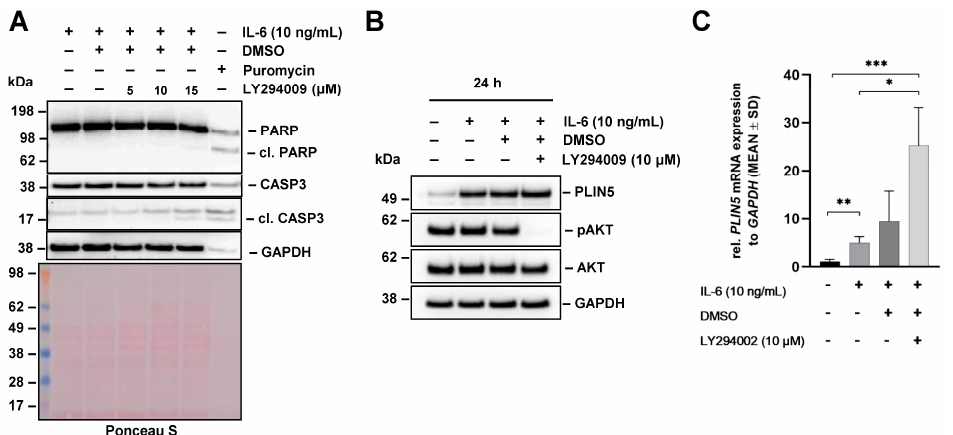
Figure 7. Effects of PI3K inhibitor LY294002 on IL-6-mediated PLIN5 upregulation in Hep3B cells. ( A ) Hep3B cells were pretreated with the indicated concentrations of PI3K inhibitor LY294002 for 1 h and then treated with IL-6 (10 ng/mL) for 24 h. Cell extracts were prepared and tested by Western blot analysis for PARP and cleaved caspase-3 (CASP3). Cell extracts prepared from cells that were treated with Puromycin served as control. GAPDH detection and Ponceau S staining served as controls to demonstrate equal protein loading. ( B ) PLIN5 expression and phosphorylation of AKT (downstream target of PI3K) analyzed by Western blot demonstrated that LY294002 has no influence on IL-6-induced PLIN5 protein expression. ( C ) Effect of LY294002 on PLIN5 mRNA expression was tested by RT-qPCR. Significant differences between the groups are marked by asterisks (* p < 0.05, ** p < 0.01, *** p < 0.001).